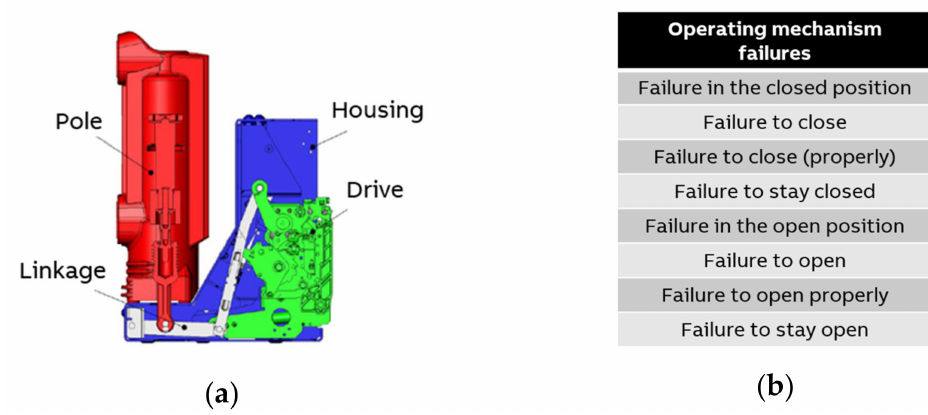
Figure 6. ( a ) Typical medium voltage circuit breaker (CAD model); ( b ) Operating mechanism failures of circuit breakers according to